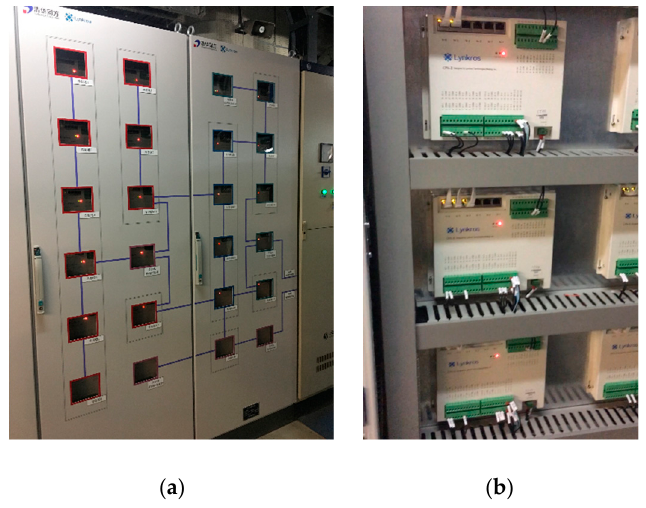
Figure 8. ( a ) Decentralized control cabinet; ( b ) Intelligent node (CPN).